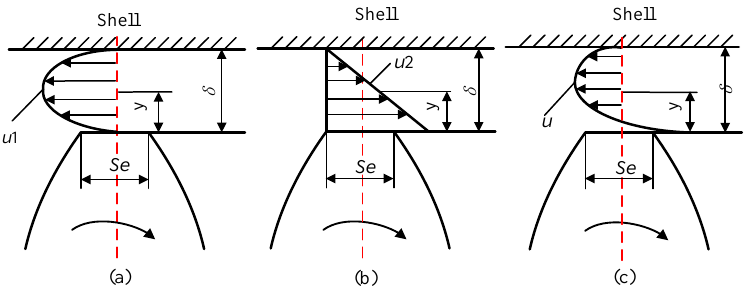
Figure 3. Gear pump radial leakage: ( a ) differential pressure flow; ( b ) shear flow; ( c ) synthetic flow. According to [12], the radial leakage